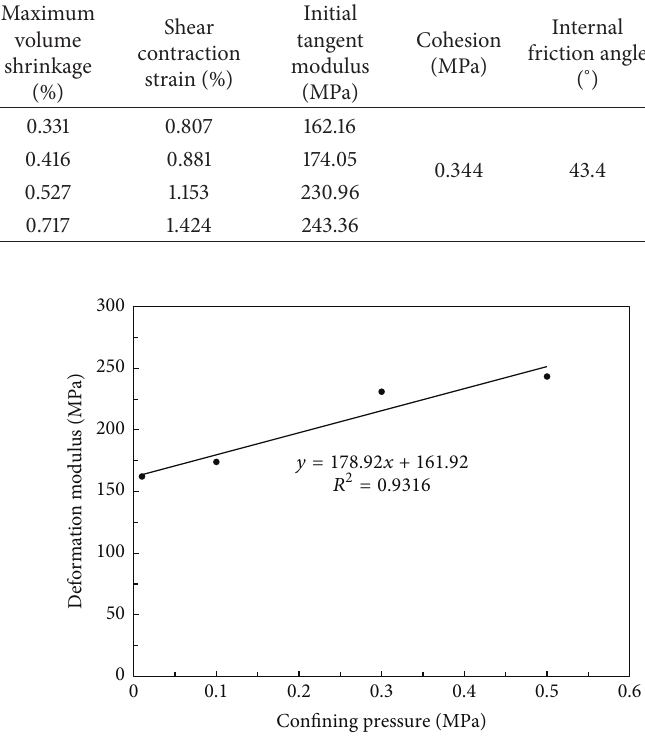
Figure 4: Relationship of confining pressures and deformation modulus of simulated soft rock specimen.